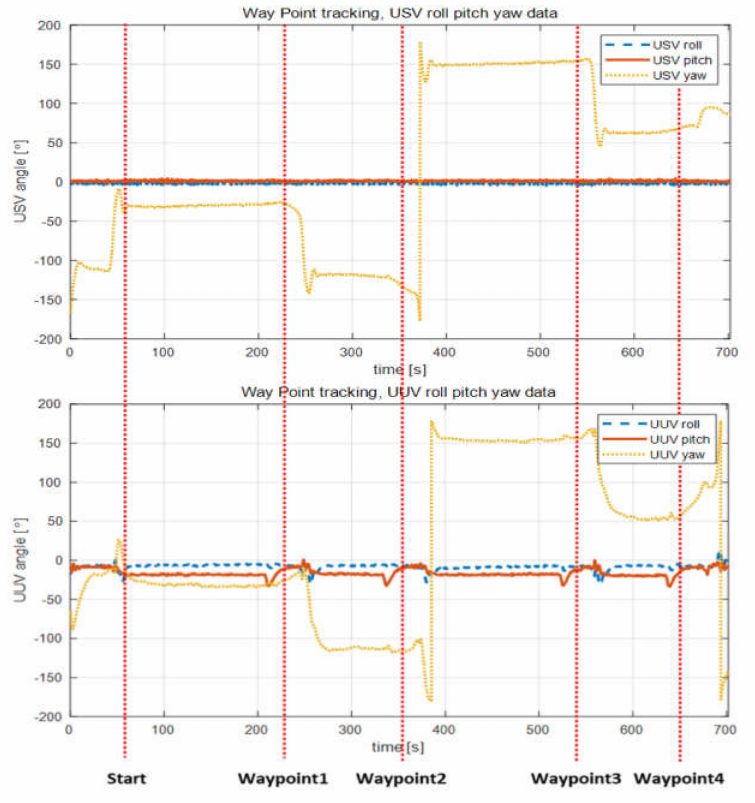
Figure 26. Attitude values of USV and UUV during waypoint